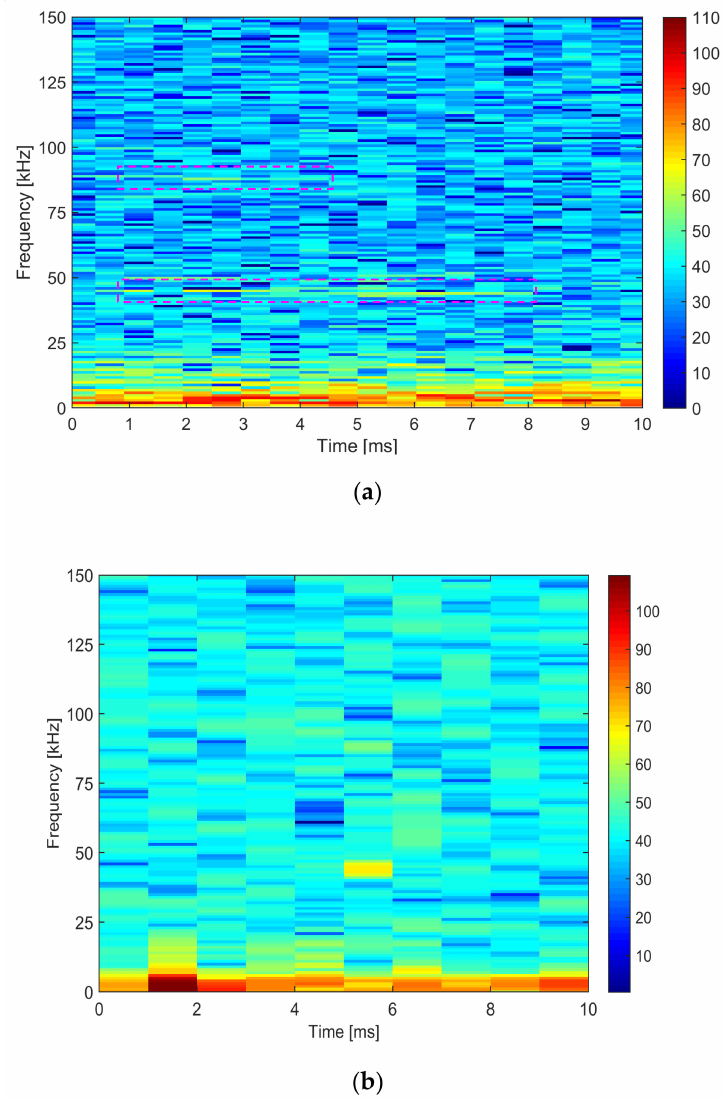
Figure 8. Black SMPS tested at 90% of rated power: ( a ) WPT spectrum obtained with db15 , L = 9, ∆ f = 976 Hz; and ( b ) STFT spectrum with ∆ f = 1 kHz and time step ∆ t = 1